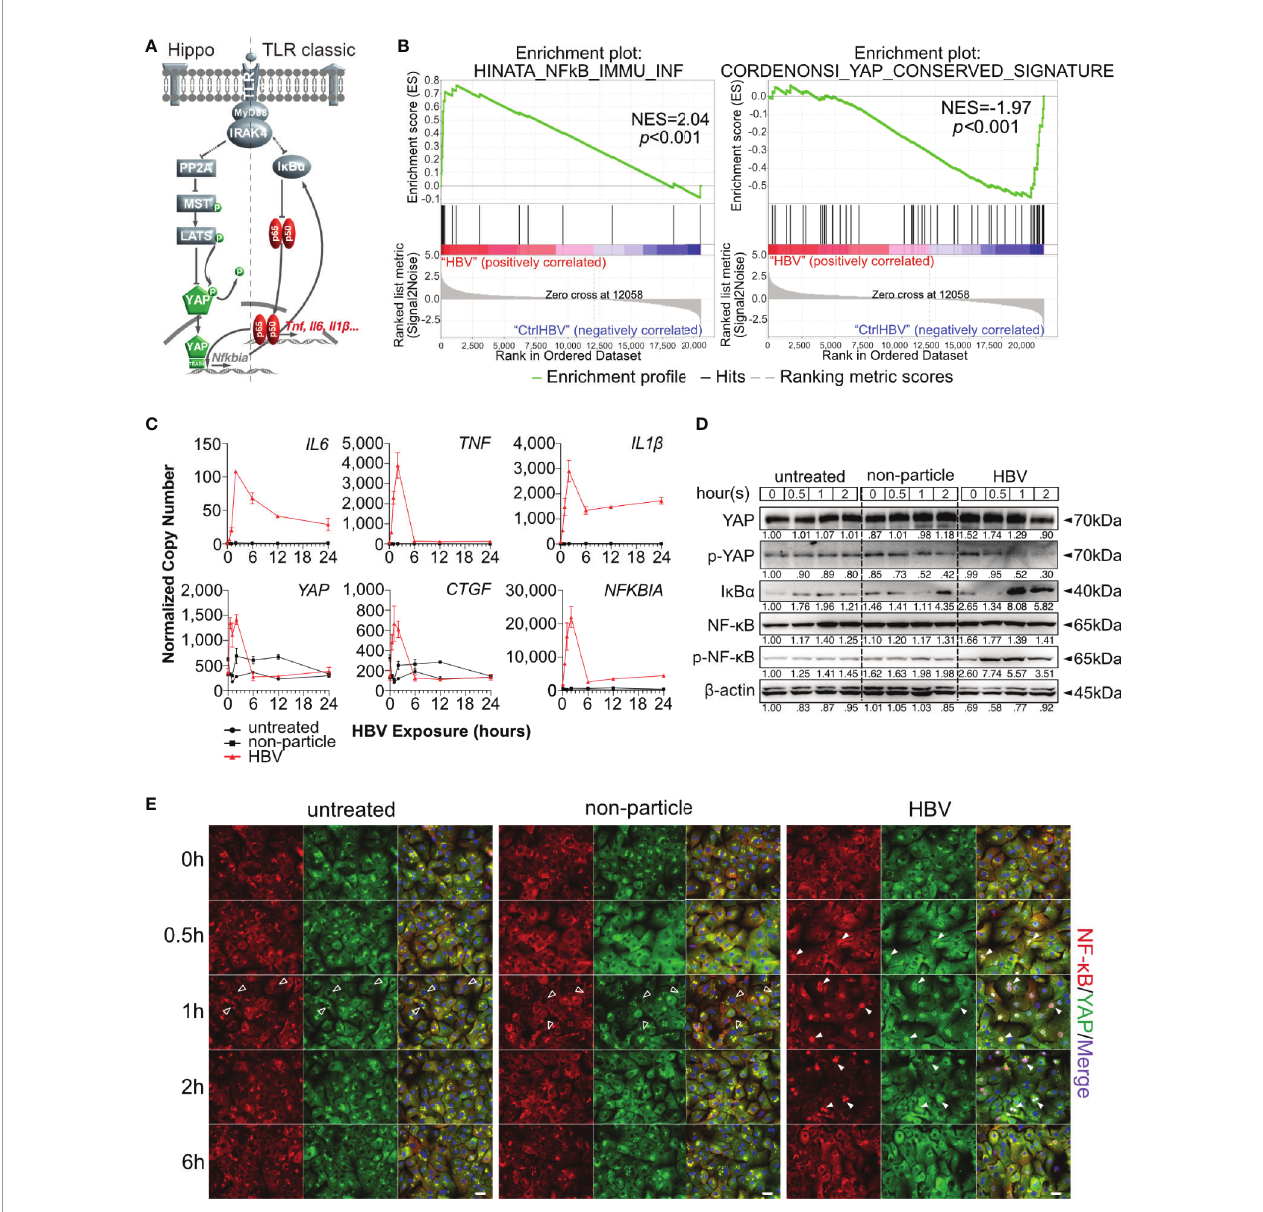
FIGURE 1 | Hippo signaling is affected during HBV-induced innate immunity in primary human hepatocytes. Hypothesis of TLR-associated Hippo pathway activation (A) . Gene set enrichment analysis of GSE69590 comparing HBV-infected primary human hepatocytes (40h) and mock control gene sets (B) . Primary human hepatocytes (PHHs) from four different donors were treated with cell culture-derived HBV (MOI of 1,000) for different lengths of time. Gene expression of IL6 , TNF , IL1 b , YAP , CTGF and NFKBIA was determined by quantitative PCR (C) , (normalized to ACTB , mean ± SEM, n=4). Western blotting was performed to determine the expression of PP2A, phosphorylated PP2A, MyD88, MST1/2, phosphorylated MST1/2, YAP, phosphorylated YAP, I k B a , NF- k B and phosphorylated NF- k B after the exposure in PHHs to HBV. Gel images were obtained with ADVANCED Fluorescence and ECL Imager, representative of n=4 (D) . Representative ICC staining images were obtained with Zeiss AxioObserver.Z1 and Apotome (40x objective) to visualize the intracellular localization (E) of YAP (green) and NF- k B (red), raw images were subsequently proceeded with Image J software, n=3 independent experiments. Arrow heads highlight nuclear exclusion (empty arrows) or nuclear translocation (full arrows) of transcription factors. Scale bar, 20 m m; kDa,